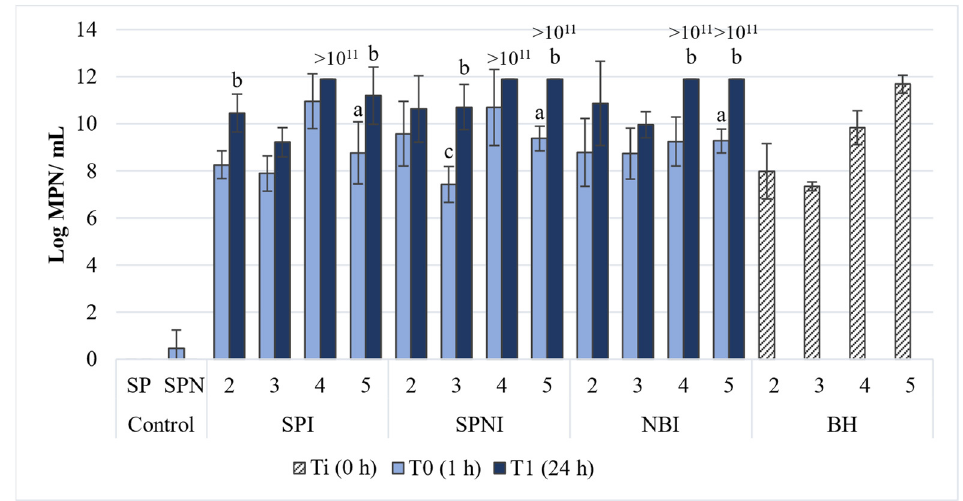
Figure 1. Abundance of hydrocarbon degraders, evaluated by the most-probable number (MPN) method, for the lyophilized bacterial strains CPN2 (2), CPN 3 (3), 1.7 L (4), and their consortium (5) (mean value, standard deviation, n = 3) after direct application in BH medium (BHI), after 1 h (T0) and after 24 h (T1) of incubation in the treatments SPI (sterile seawater + petroleum + inoculum), SPNI (sterile seawater + petroleum + nutrients + inoculum), NBPI (nutrient broth + petroleum + inoculum). a—significant differences comparing all treatments with the values from BHI treatment, for each lyophilized bacterium (or their consortium); b—significant differences comparing with the values from T0, within the same treatment and type of lyophilized bacteria; c—significant differ- ences comparing different type of lyophilized bacteria, in the same treatment at T0.